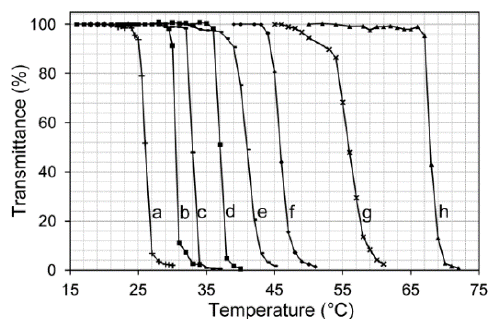
Figure 11. Transmittance as a function of the temperature for 2 mg mL −1 aqueous solutions of ( a ) PDEGMA; ( b–f ) Poly(OEGMA-co-DEGMA): ( b ) 14:86, ( c ) 15:85, ( d ) 24:76, ( e ) 31:69, ( f ) 50:50, ( g ) 79:21 mole ratio; and ( h ) POEGMA Tcp was taken at 50% drop of transmittance.